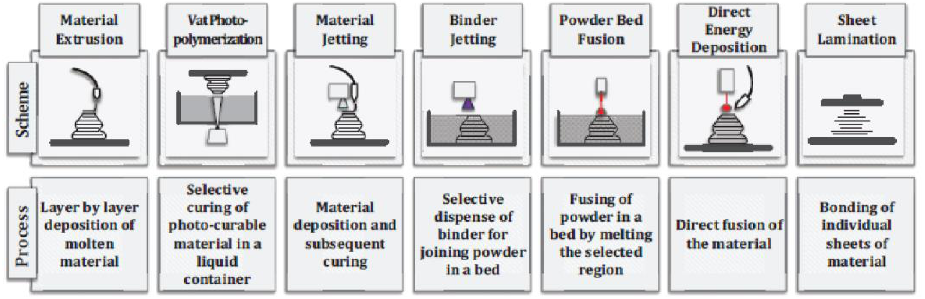
Figure 2. Categorization of additive manufacturing